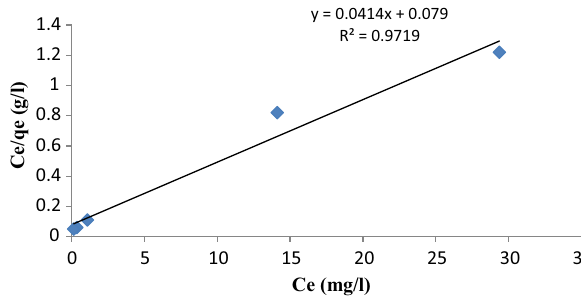
Fig. 6 Langmuir isotherm plot of Cd 2+ adsorption onto Opi soil